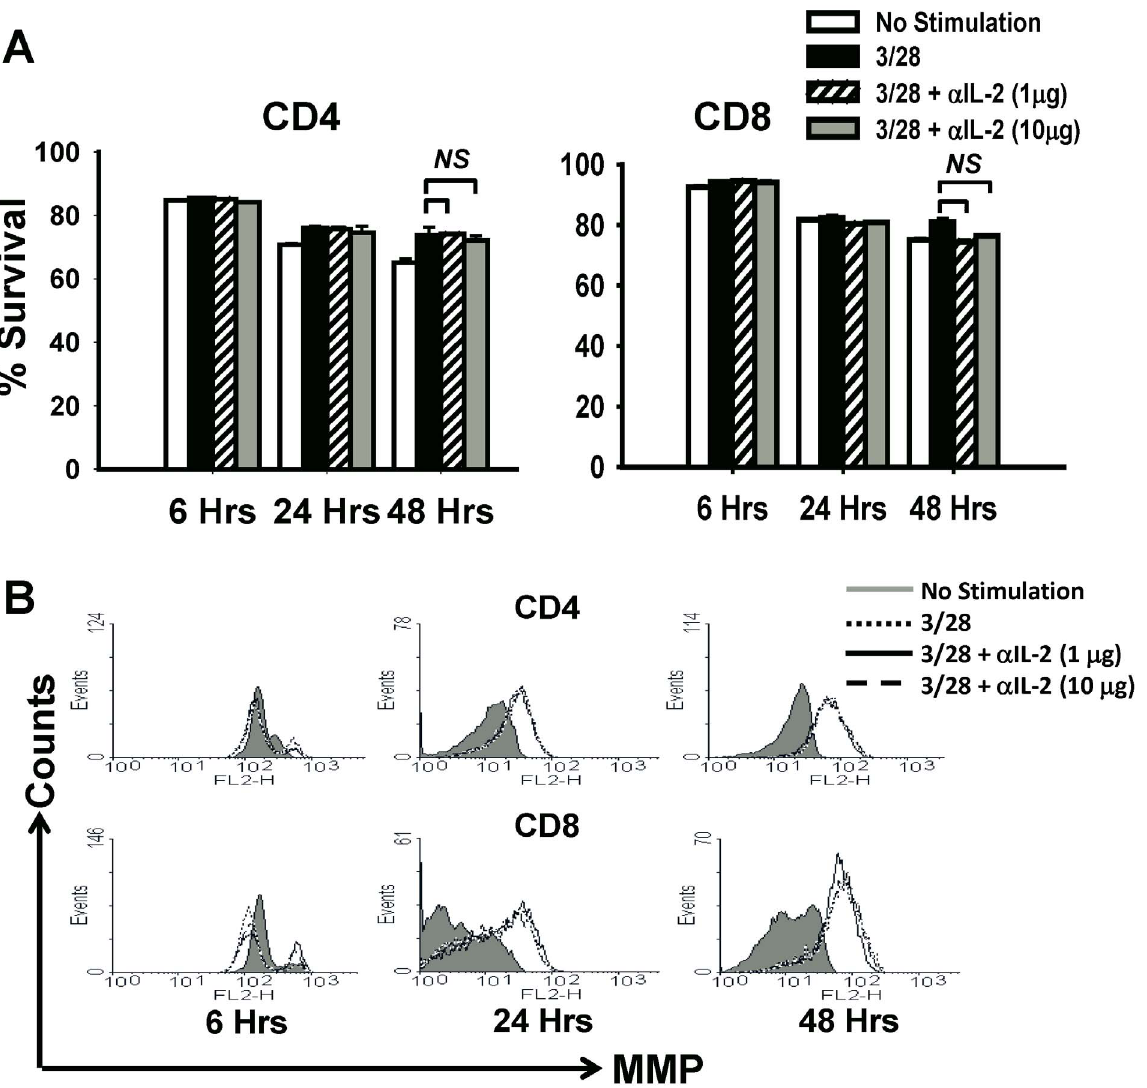
Figure 2. Constitutive expression of Bcl-2 rescues the survival of CD8 + T cells under IL-2 deprivation. CD4 + CD25 2 and CD8 + CD25 2 T cells were purified from Bcl-2 Tg mice and stimulated with anti-CD3/CD28 mAbs in the presence or absence of neutralizing IL-2 mAb at two different concentrations as indicated. Some cells were left unstimulated (no anti-CD3/CD28) and were used as negative controls. A total of 5 6 10 4 cells per well were cultured in flat-bottom 96-well plates and harvested for analysis at the indicated time points. ( A ) Harvested cells were stained with Propidium Iodide (PI) to measure cell survival by flow cytometry. Bar graphs show the percentage survival in each group (n=3) measured as the frequency of PI negative cells. ( B ) Histograms represent the mitochondrial membrane potential in the harvested cells measured by flow cytometry (with higher fluorescence depicting a hyper-polarized state of mitochondria) at indicated time points. The figure shows results from one representative experiment which was repeated three times with similar results. Bars indicate average value 6 SD obtained from three culture wells (technical triplicates) in each experimental group.